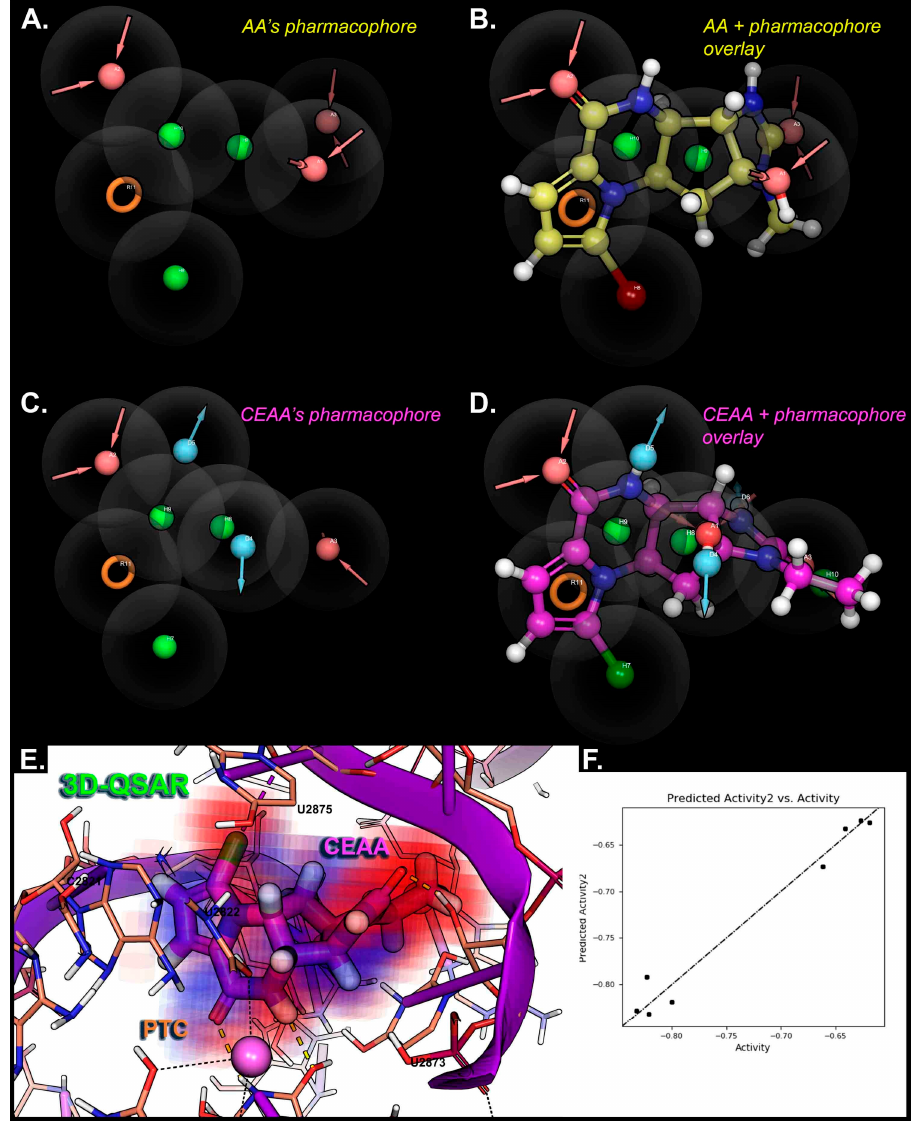
Figure 6. Three-dimensional-quantitative structure activity relationship (QSAR) modeling for AA analogues binding within the PTC of the ribosome. ( A ) AA pharmacophore hypothesis is generated for the most useful features that can selectively bind and be used for 3D-QSAR modeling. ( B ) Overlay of the AA compound structure with the pharmacophore features for AA that have some interactional basis with PTC. ( C ) CEAA pharmacophore hypothesis is given for features most commonly occurring in PTC binding during modeling and dynamics studies. ( D ) Overlay of the CEAA compound structure with the pharmacophore features having an interactional basis with PTC. ( E ) 3D-QSAR map for CEAA within the PTC as bound. Here, the factors from a PLS-2 quantify the distribution of contributions: electrostatics (electron-withdrawing), hydrophobic/non-polar, and H-bond donors. The combined effects are “voxelized” into 0.5-Å 3 units with red-to-blue color scheme giving the essential interaction sites on CEAA with the PTC (ribosome). ( F ) Graph for correlation between the prediction and actual activities of the 8 AA analogs is given, where R 2 > 0.97, SD 0.019, RMSE 0.01, and Pearson 0.987. This demonstrates the accuracy of our compound affinity prediction in this particular system.